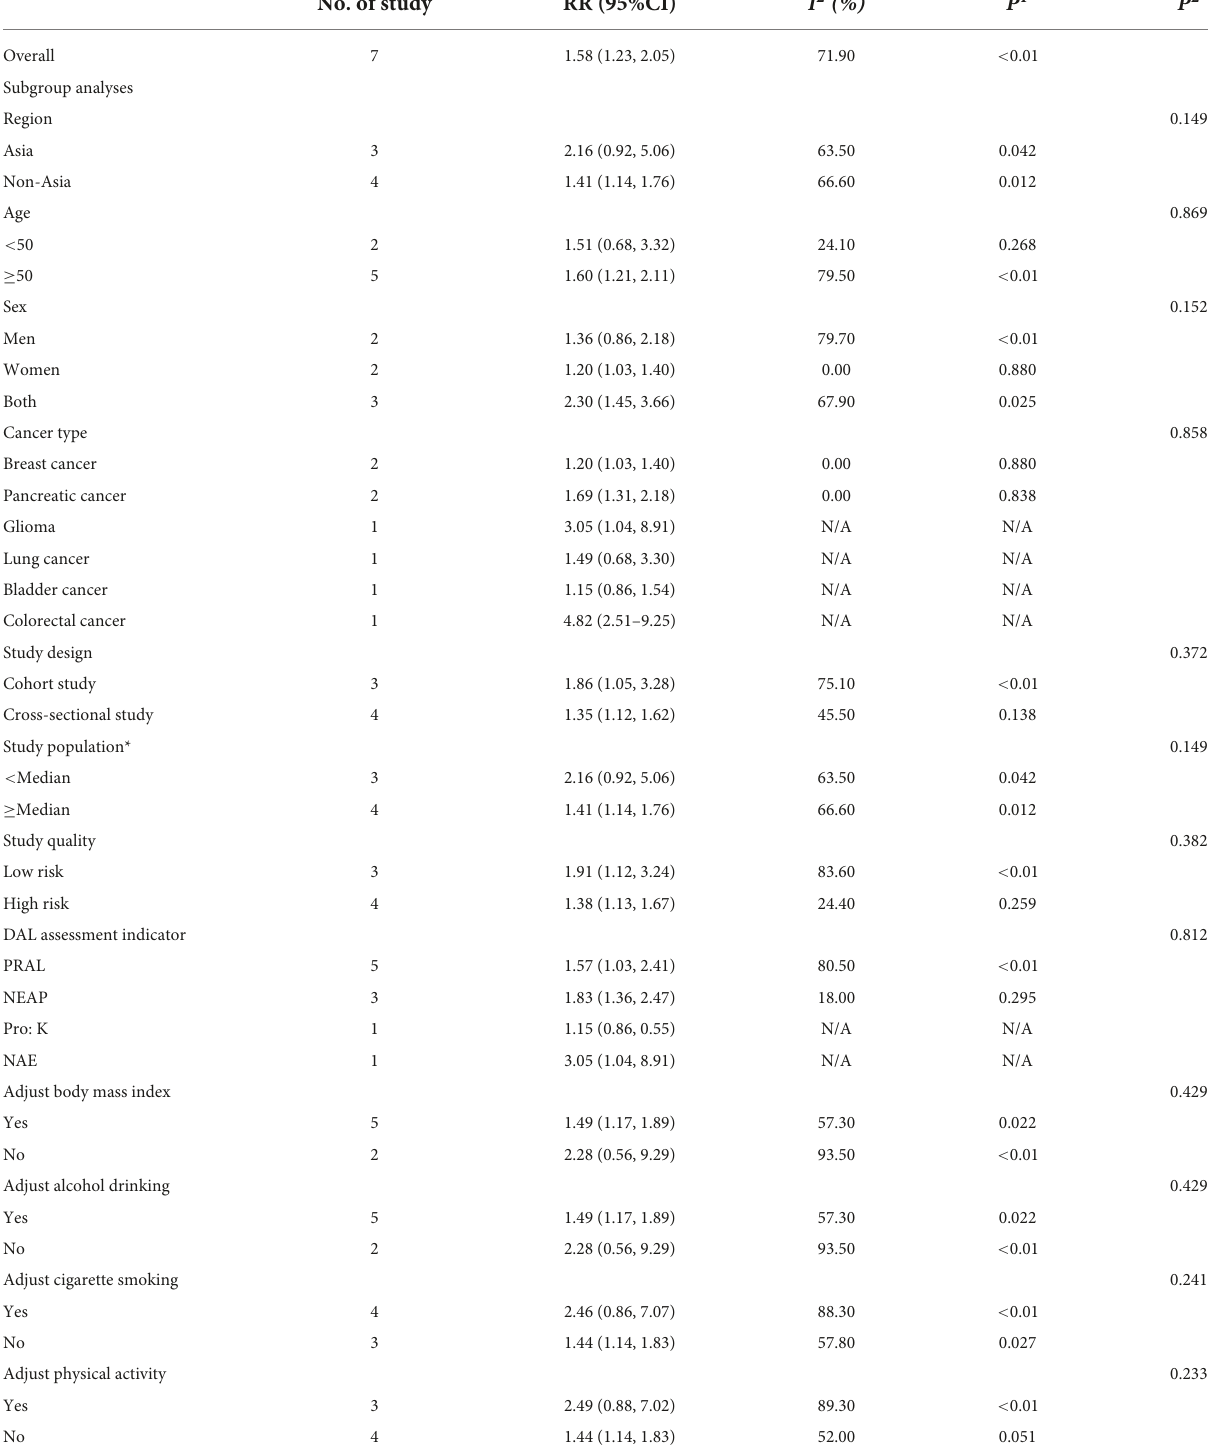
TABLE 5 Summary risk estimates of the association between dietary acid load and risk of cancer (highest vs. lowest). No. of study RR